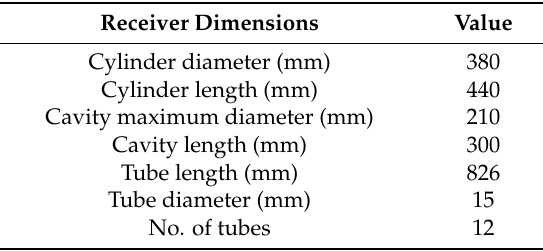
Figure 2. Scheme of the receiver geometry. Table 2. Solar receiver main dimensions.